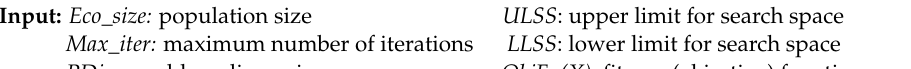
Algorithm 1: Hybrid SOSK-means clustering pseudocode